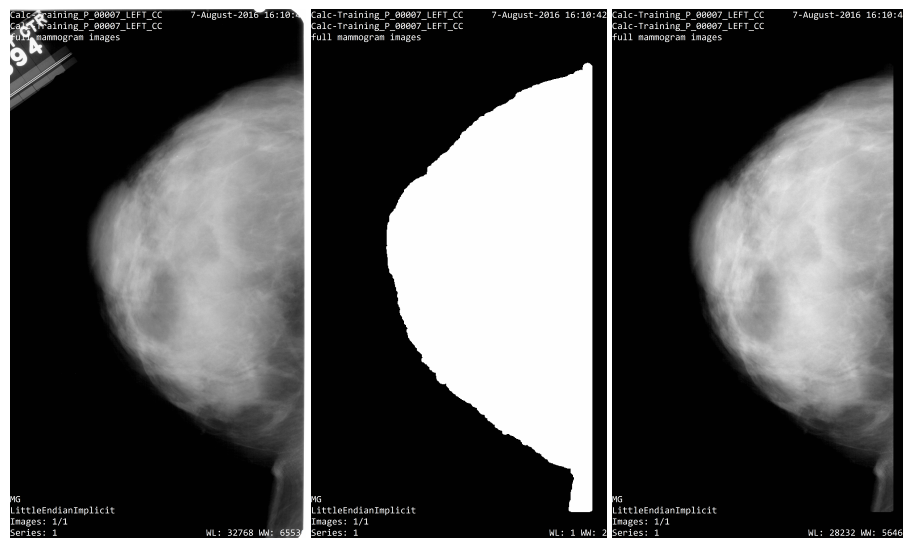
Figure 9. Segmentation process. ( left ) Image from CBIS_DDSM; ( center ) segmentation mask; ( right ) ROI segmentation.